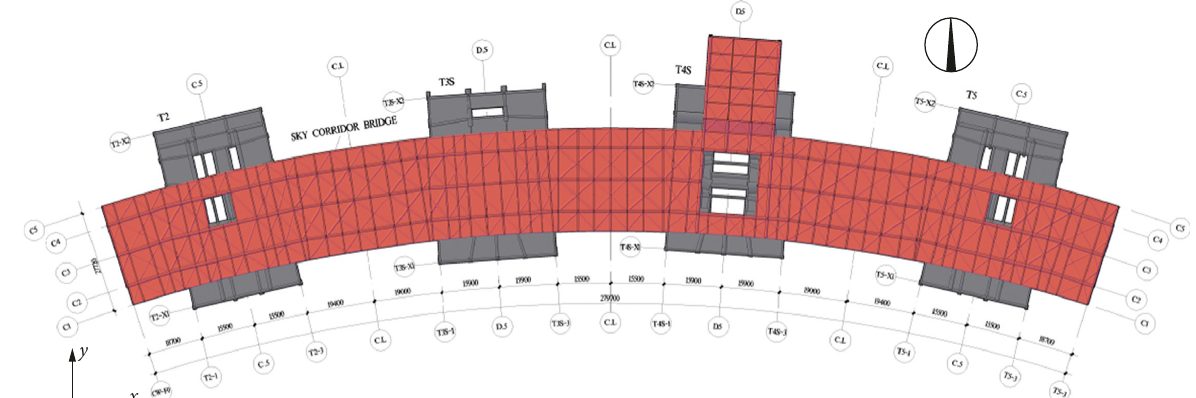
Figure 4: Structural plan layout of the towers and the sky corridor bridge.